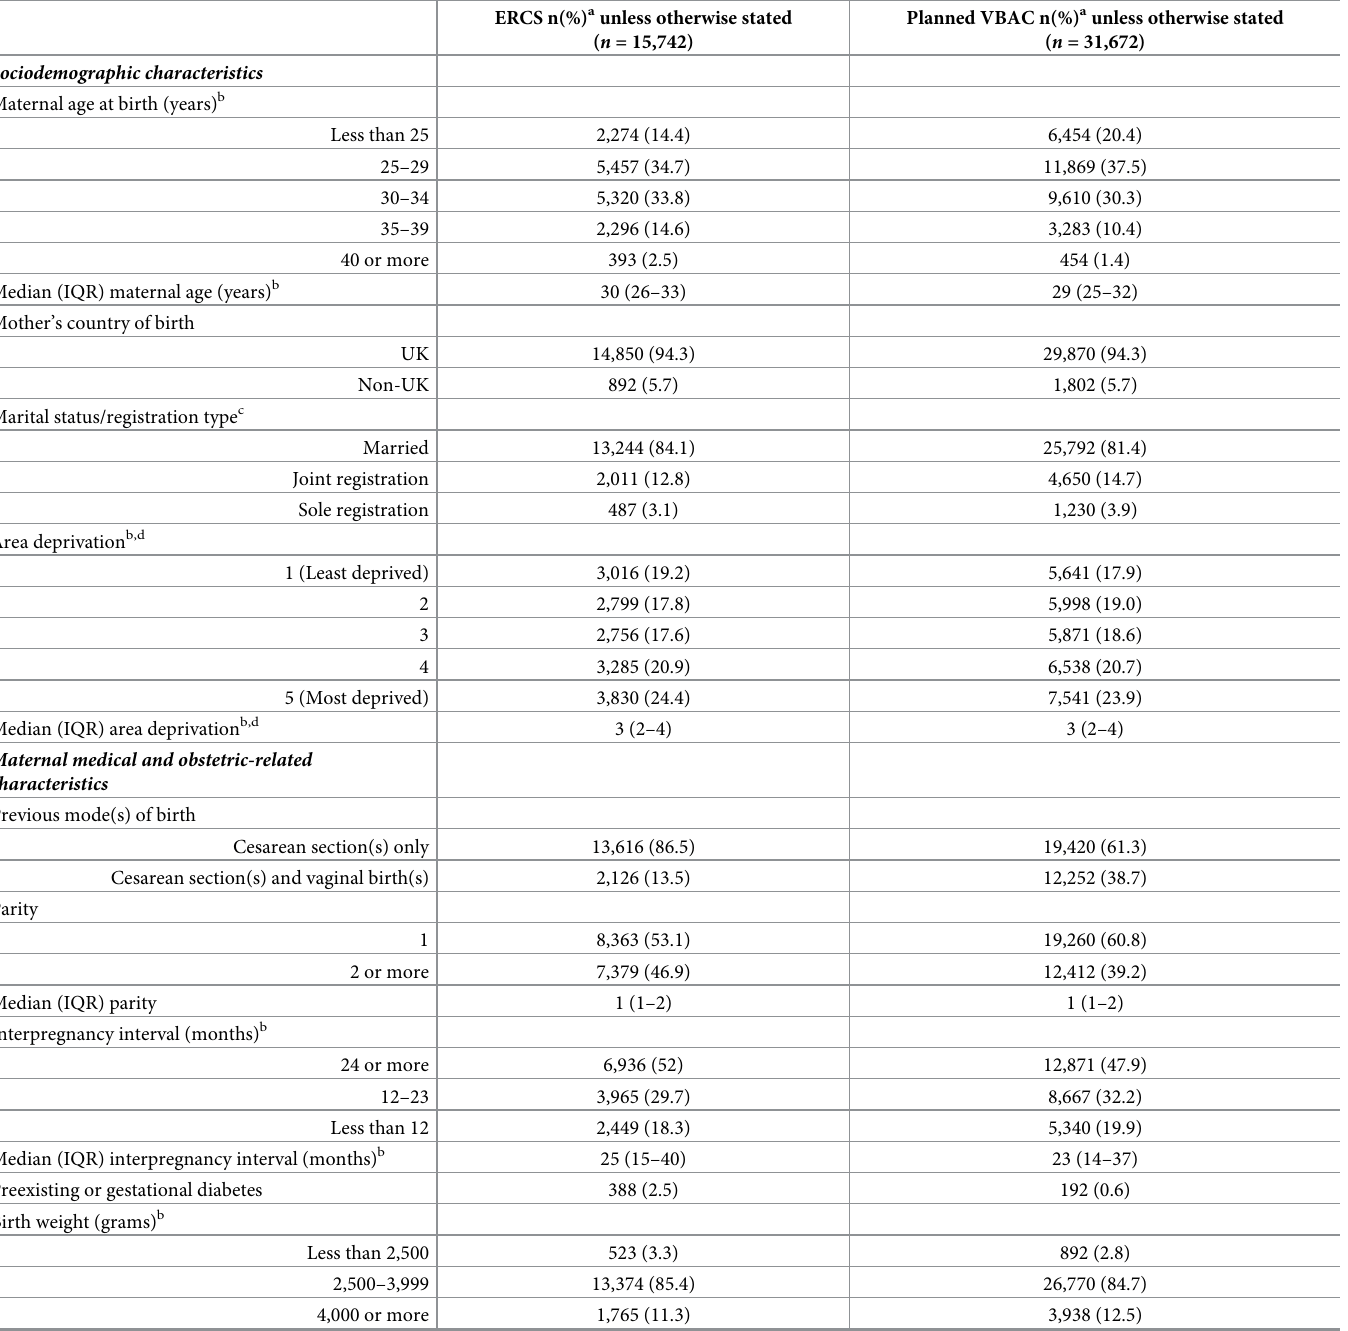
Table 1. Characteristics of the study cohort by planned mode of birth after previous cesarean